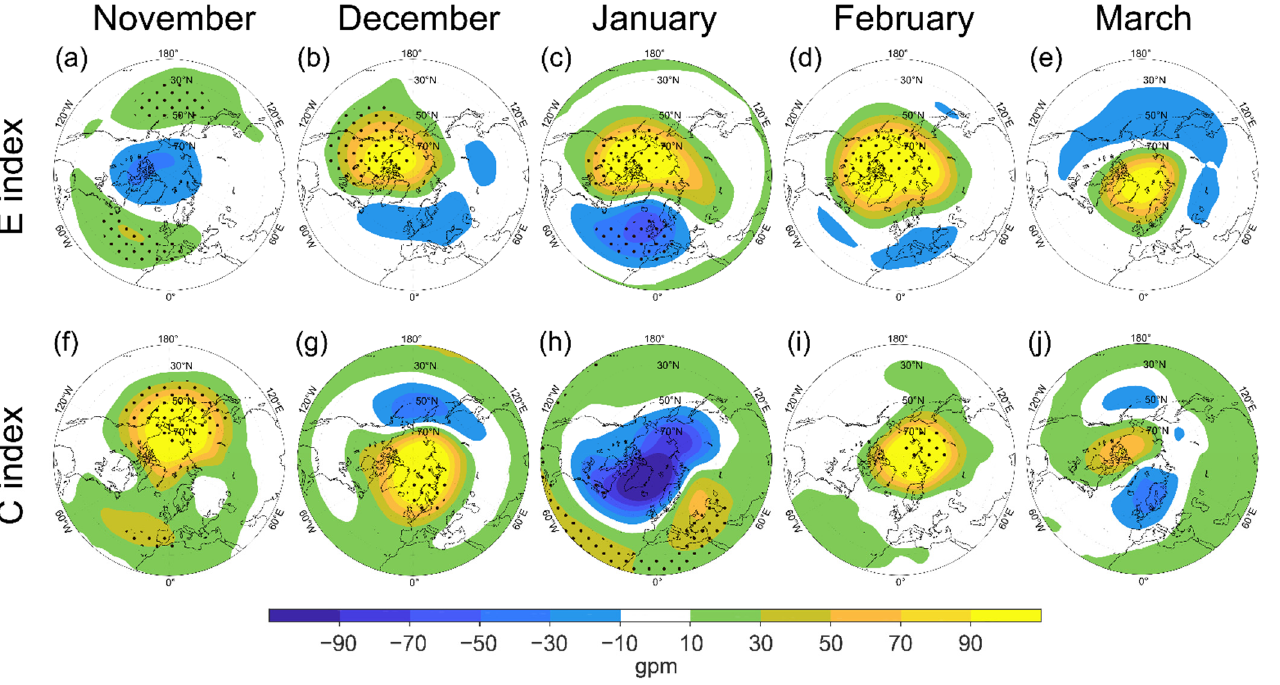
Figure 2. Regression of geopotential height anomalies at 10 hPa onto ( a – e ) E index and ( f – j ) C + index from November to March. Dotted areas represent statistically significant values at a 90% confidence level. Contour interval is 20 gpm. The outermost latitude is 20° N.